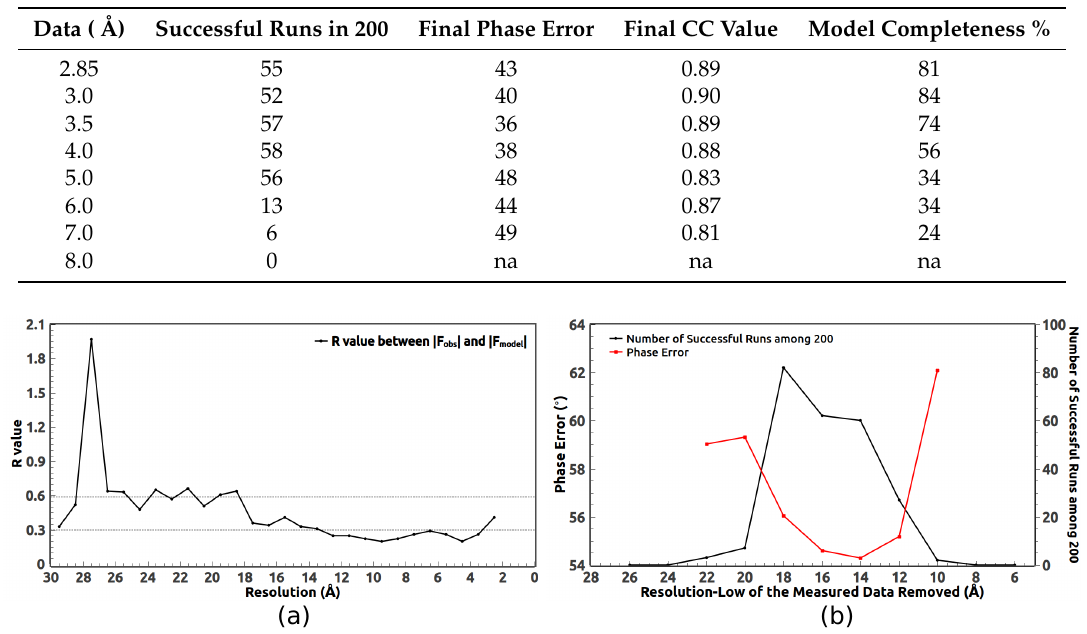
Table 1. The success rate, error metrics, and completeness of the reconstructed model for the ab initio phasing of 2JLN using data at various resolutions.